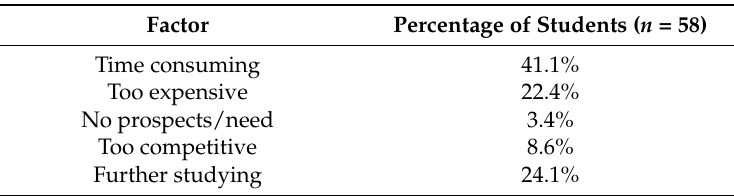
Table 6. Factors discouraging decision to